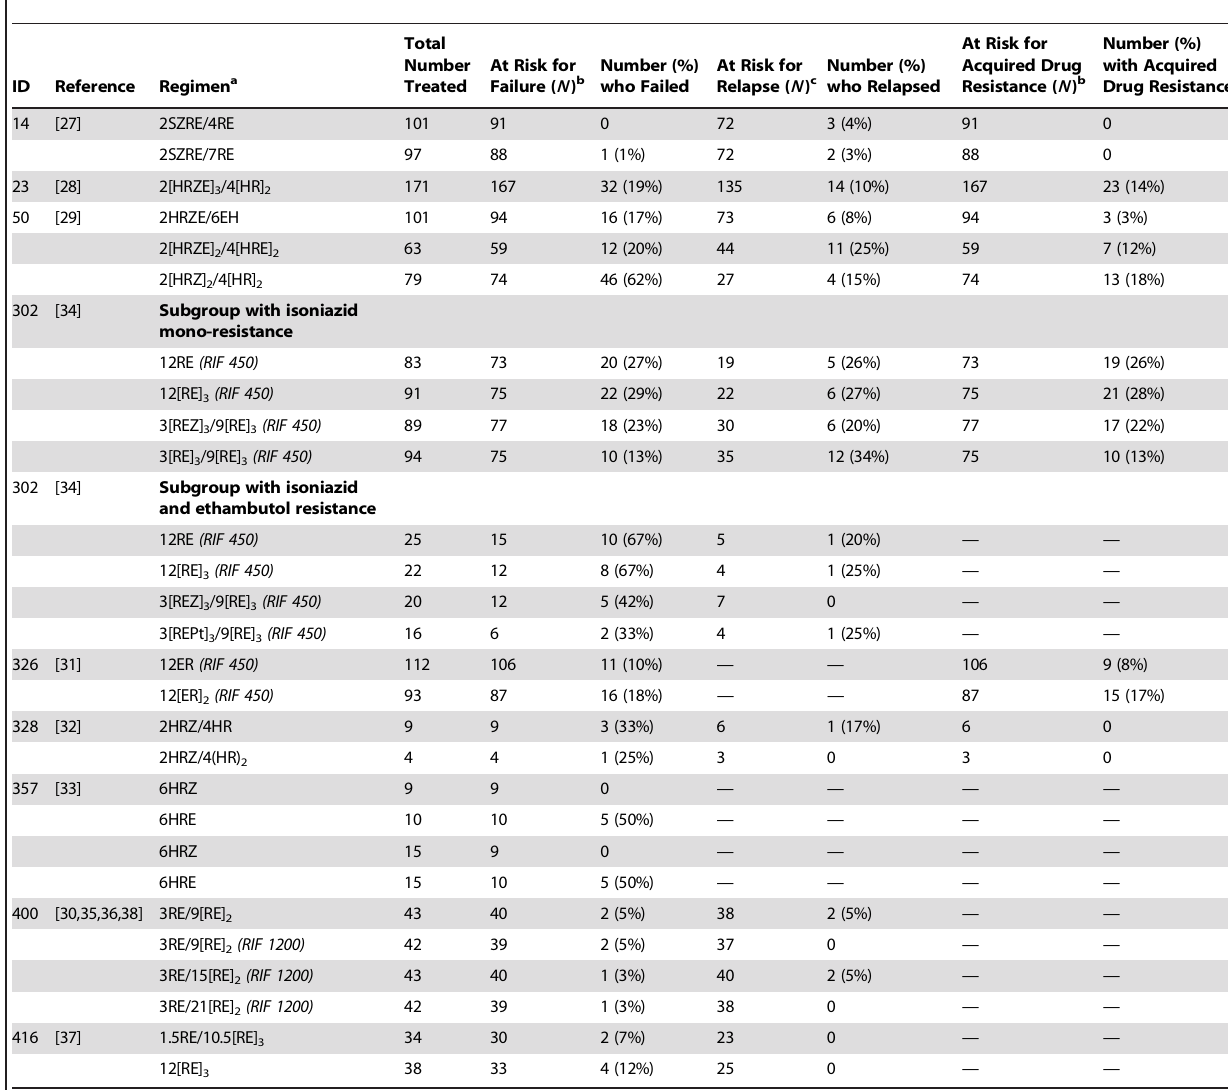
Table 2. Regimens and results in randomized trials in previously treated patients with INH